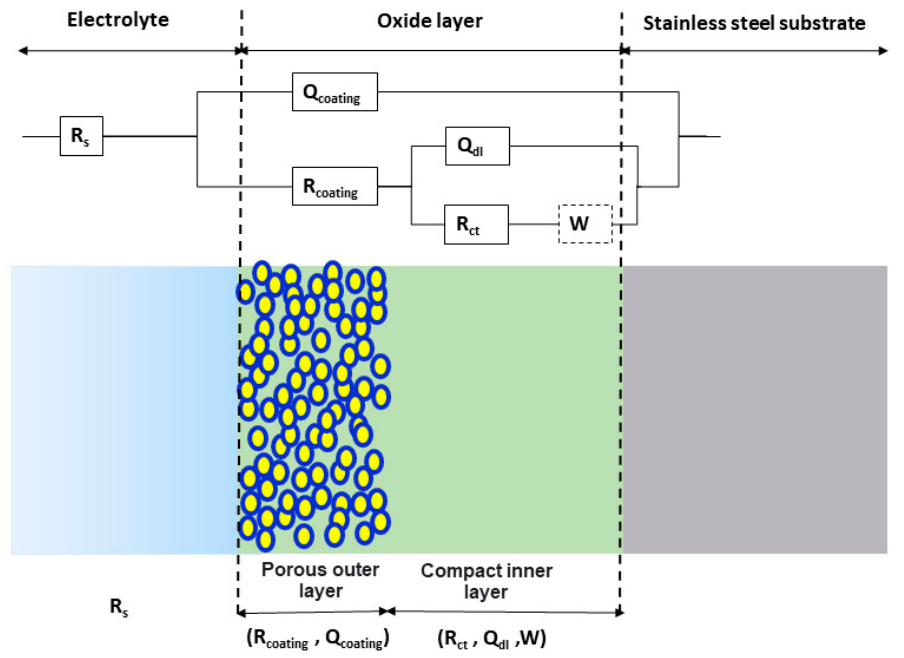
Figure 7. Schematic representation of equivalent circuit components used for modeling EIS data. Table 2. EIS parameters obtained from fitting the electrical equivalent circuit on the experimental data of SS/PbO 2 , SS/TiO 2 /PbO 2 and SS/TiO 2 /PbO 2 -10%B anodes.